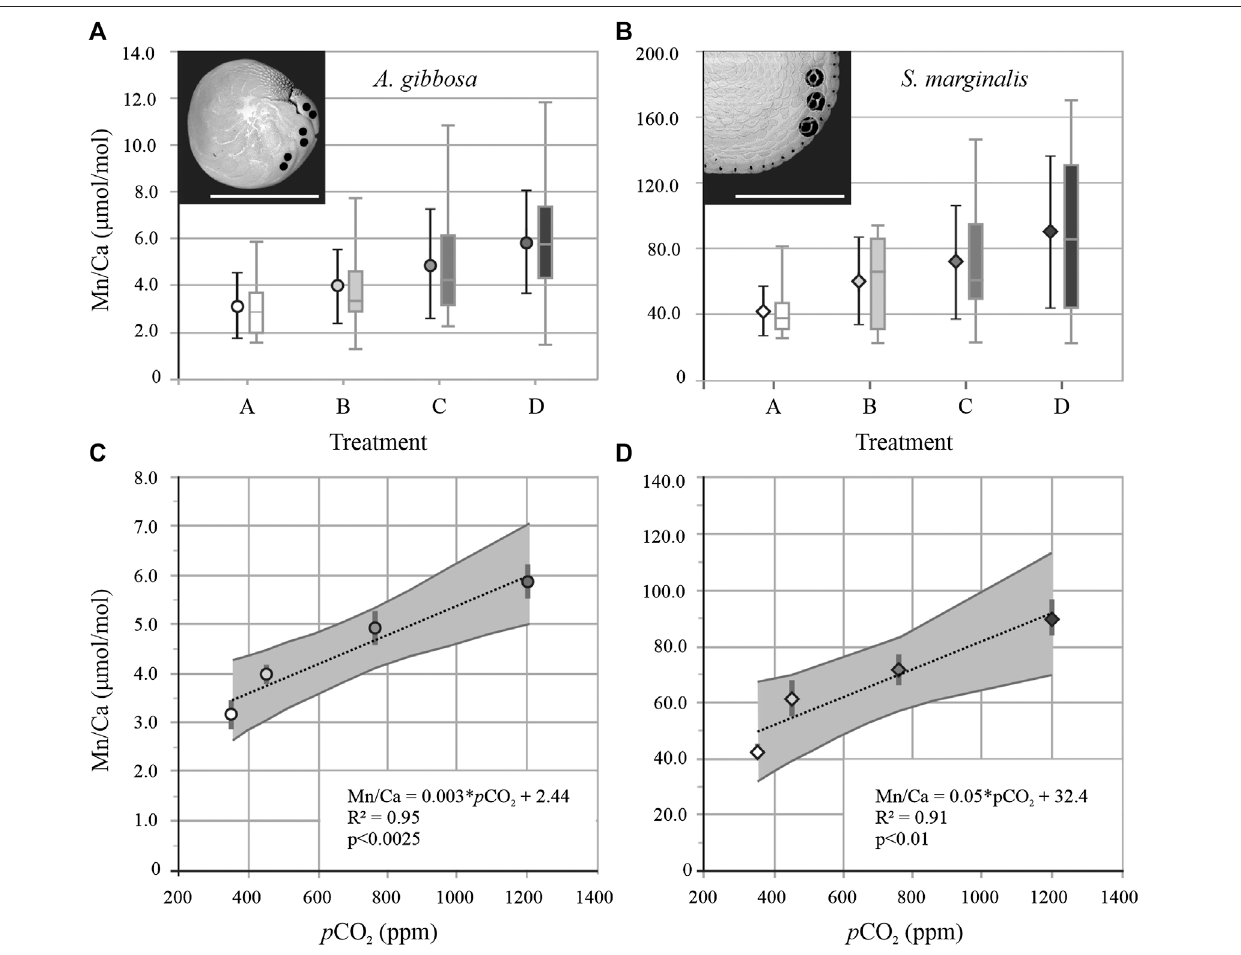
FIGURE 1 | Average foraminiferal Mn/Ca with standard deviation and boxplot of all datapoints per treatment A, B, C, and D for A. gibbosa ( A ; circles) and Sorites marginalis ( B ; diamonds). Insets show SEM images of both species with laser ablation spots visible. Scale bar (cid:1) 500 µm. Average Mn/Ca ± standard error (gray bar) vs. p CO 2 ,withregression lineand 95%con fi denceinterval (grayarea) for A.gibbosa ( C ;Mn/Ca (cid:1) 0.003 × p CO 2 +2.44with R 2 (cid:1) 0.95 and p < 0.0025) and S. marginalis ( D ; Mn/Ca (cid:1) 0.05 × p CO 2 + 32.4 with R 2 (cid:1) 0.91 and p <